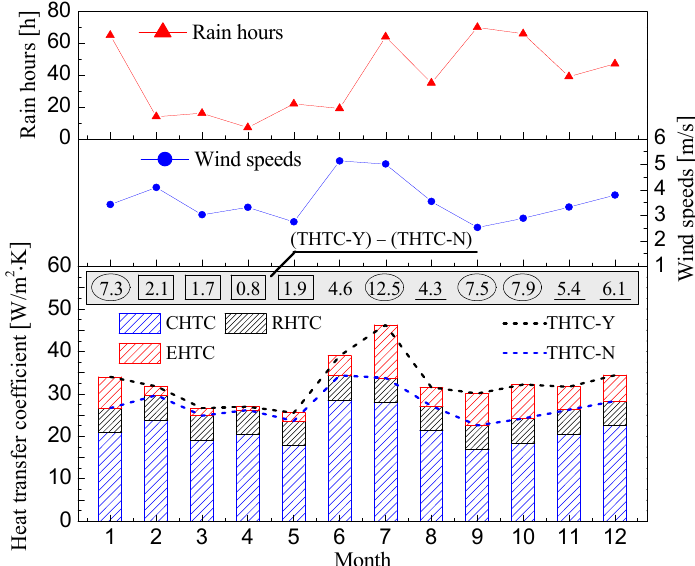
Figure 13. Monthly variation relationship between heat transfer coefficients, wind speeds, and rain hours in the tropical island region.